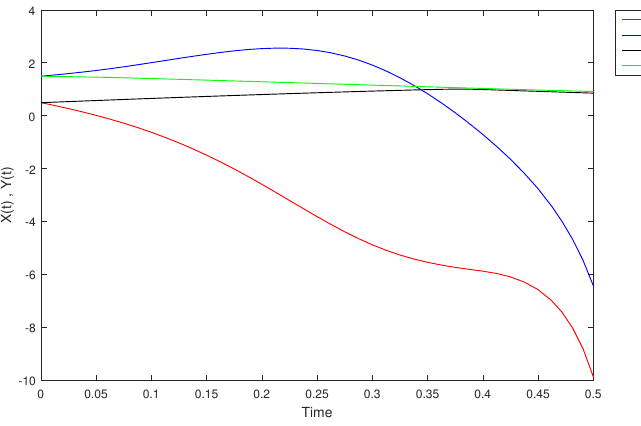
Figure 20. The solution of (11) at α = 0.0. At α -level = 0.5, the solution is in Figure